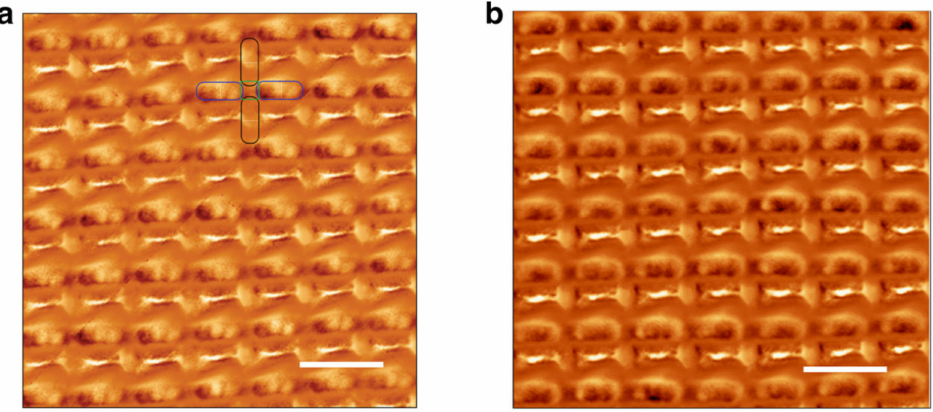
Figure 3. ( a , b ) MFM images of Py nanostructured lattice with opposite tip magnetizations. Scale bars are 2 µ m long. Reprinted from [46] and originally published under a CC-BY